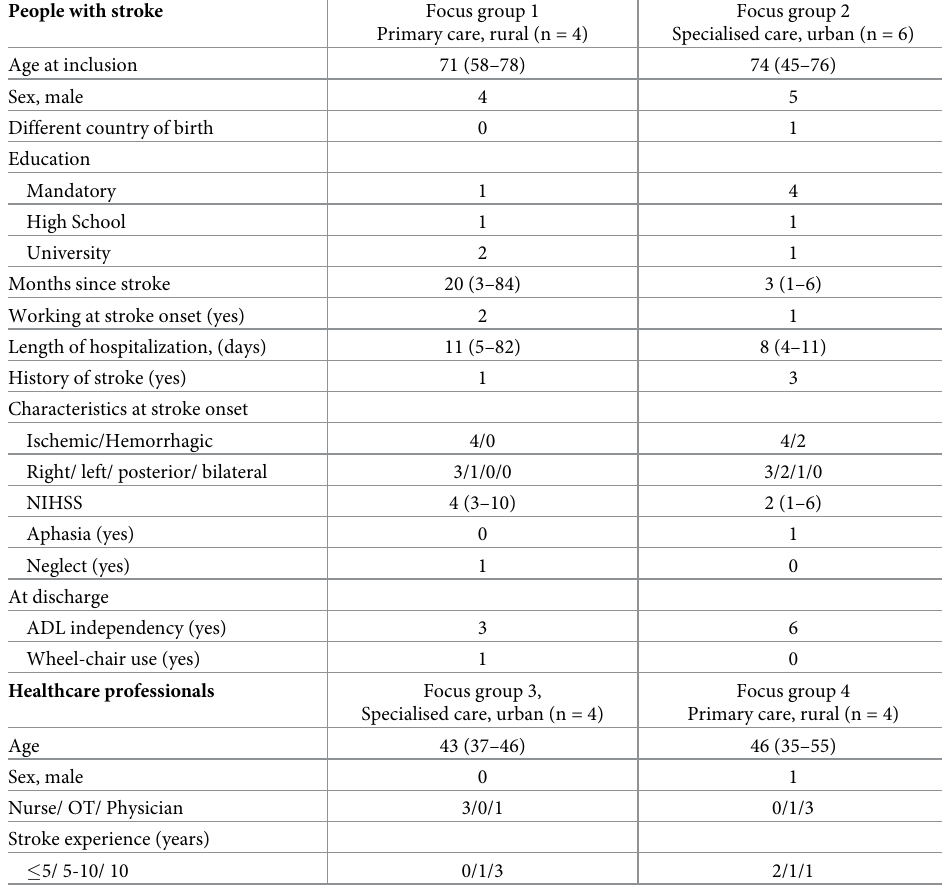
Table 2. Characteristics of all participants in the focus group discussions. Data are presented as number of persons (n) or median and